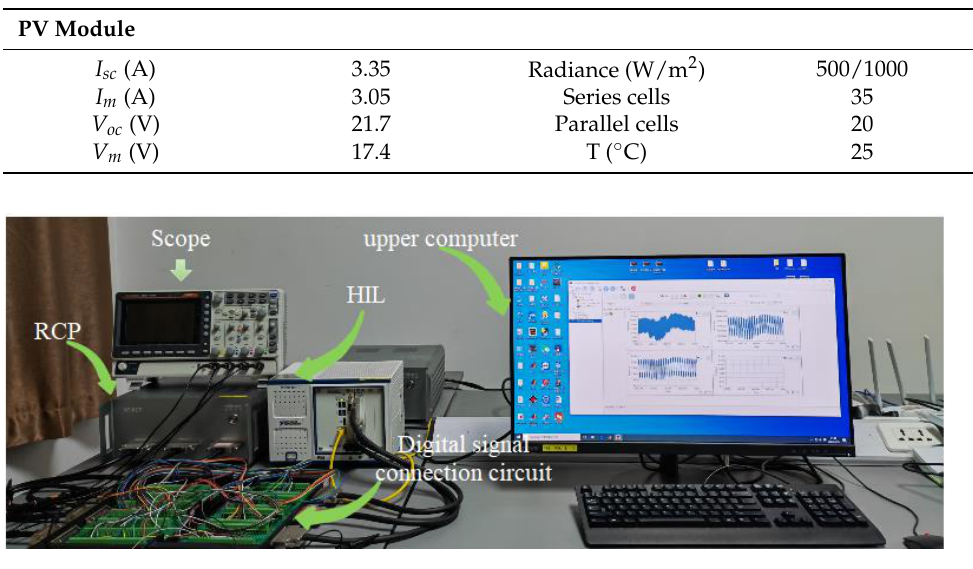
Figure 14. Platform diagram.